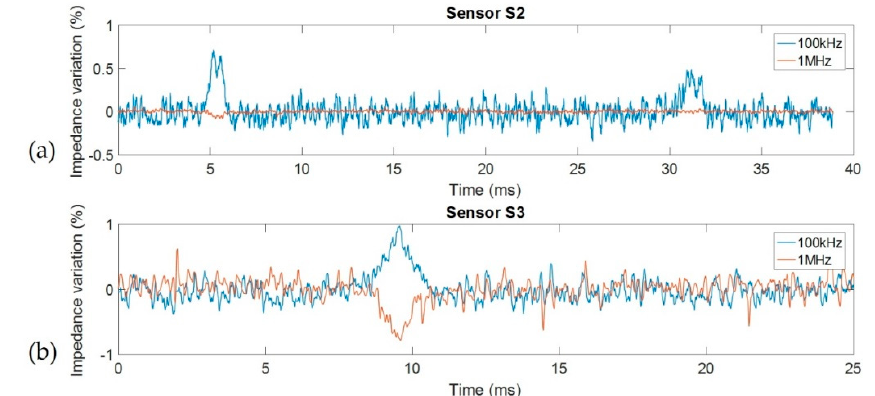
Figure 8. Impedance variation for 100 kHz and 1 MHz frequencies (in percent) during the passage of yeast cells with ( a ) first-generation sensor S1 and ( b ) second-generation sensor S4.